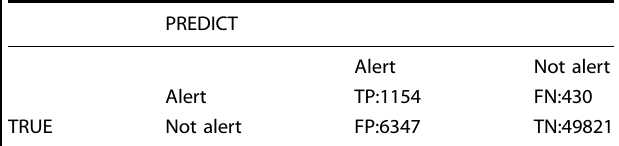
Table 10. Confusion matrix of fi nal model on fourth